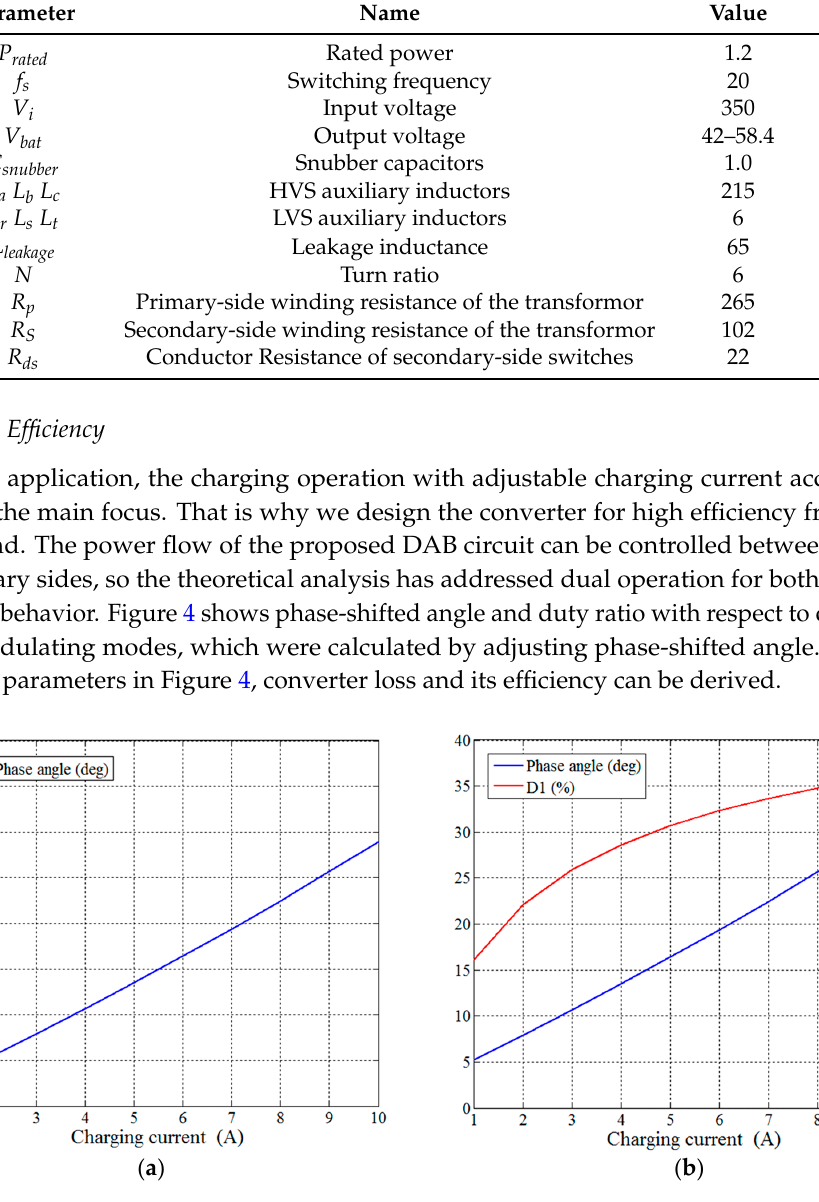
Figure 4. Modulation parameters with respect to current. ( a ) Phase-shifted modulation; ( b ) Trapezoidal modulation.